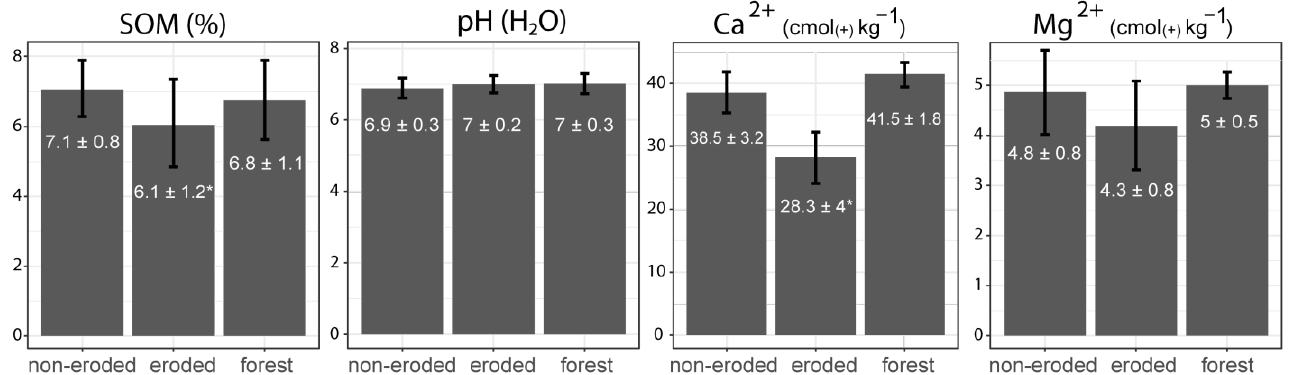
Figure 3. Variation and mean values of SOM, pH, Ca and Mg contents in the top soil layer (0 – 20 cm) among the arable (non-eroded and eroded) and forest soils. * Significant changes in the chemical properties were observed (t emp > t tbl at p ≤ 0.05); in other cases, the changes were not significant (t emp ≤ t tbl at p ≤ 0.05).